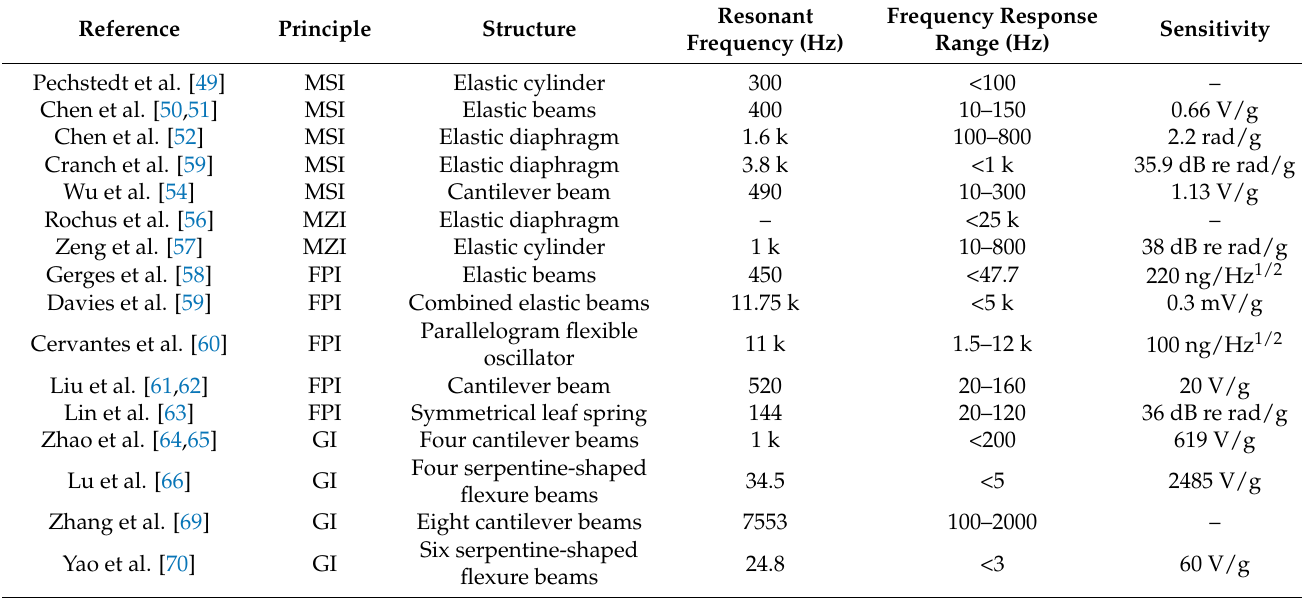
Table 3. Parameters of the accelerometer based on optical phase